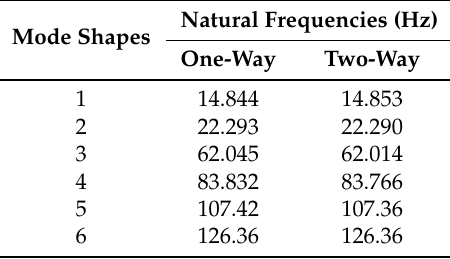
Table 3. Natural frequencies of the